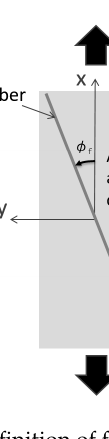
Figure 3. Definition of fiber orientation angle.